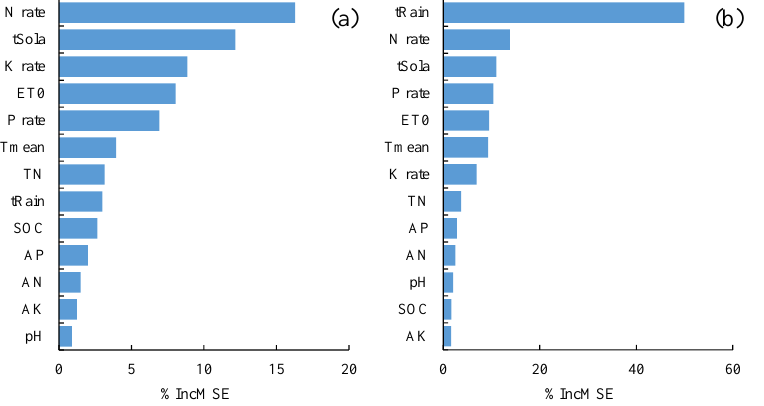
Figure 2. Grain yield and WP of various farming groups.